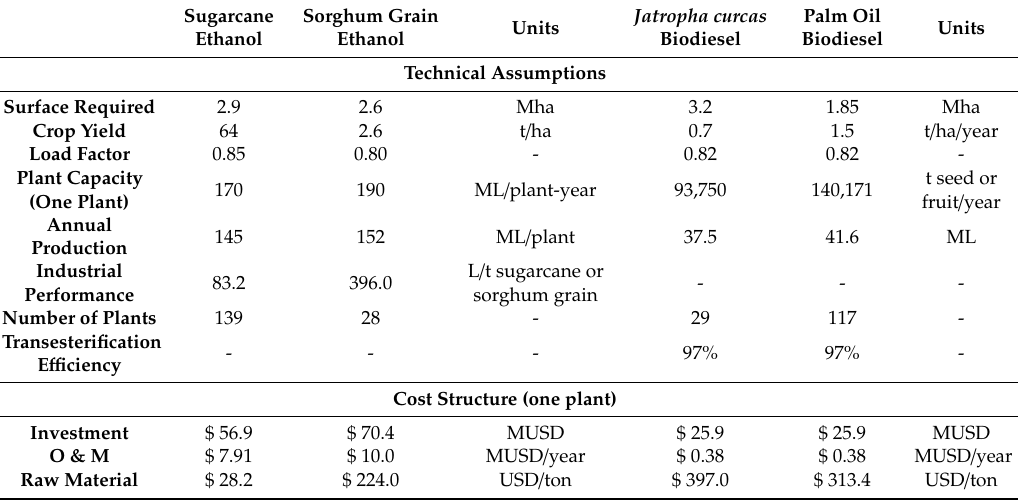
Table 9. Main technical assumptions and cost structure for